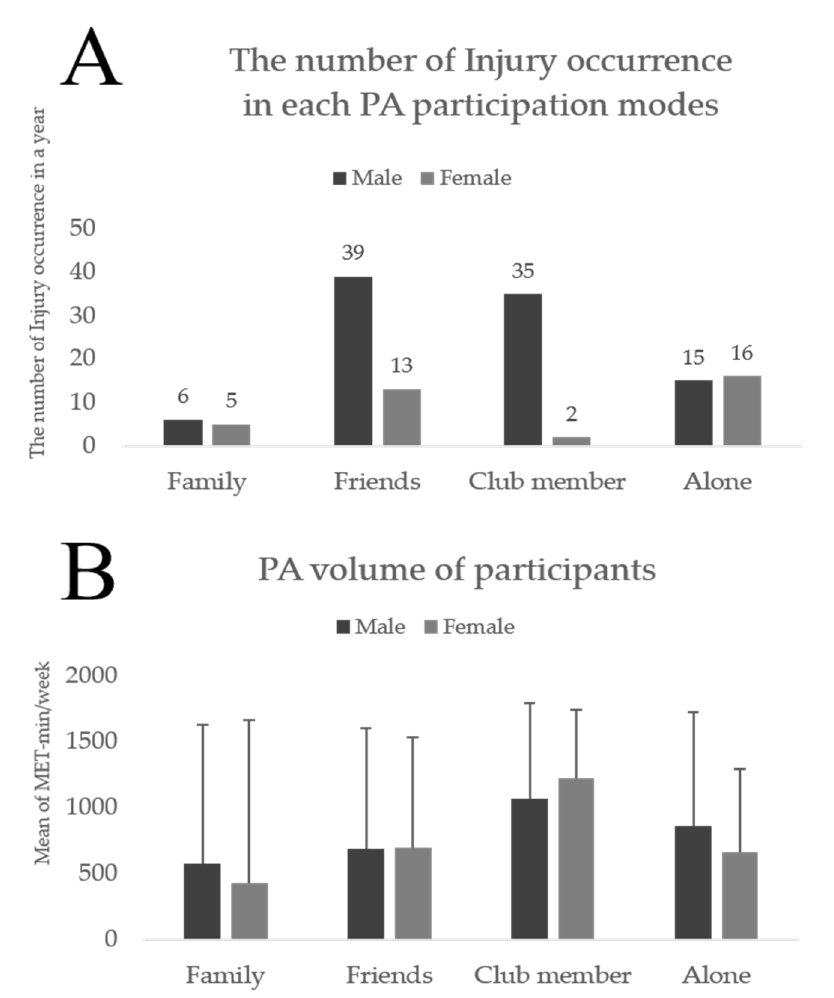
Figure 1. The comparisons of the number of injury occurrences in each PA participation mode ( A ) and the PA volumes of participants ( B ) among club member, friend, family, and alone groups. Error bars represent the 95% confidence interval.